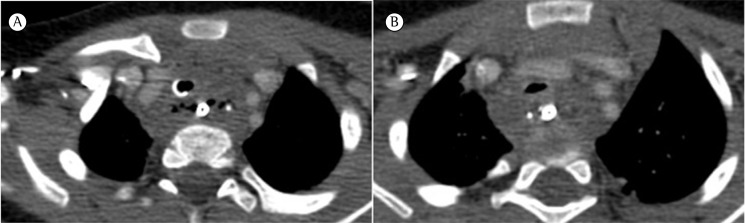
TC mostrando alargamento do mediastino superior com áreas de baixa
atenuação em torno da traqueia e das artérias supra-aórticas e veias, bem
como gás extraluminal e fragmentos metálicos (restos de corpo estranho),
sugestivos de perfuração esofágica e mediastinite.